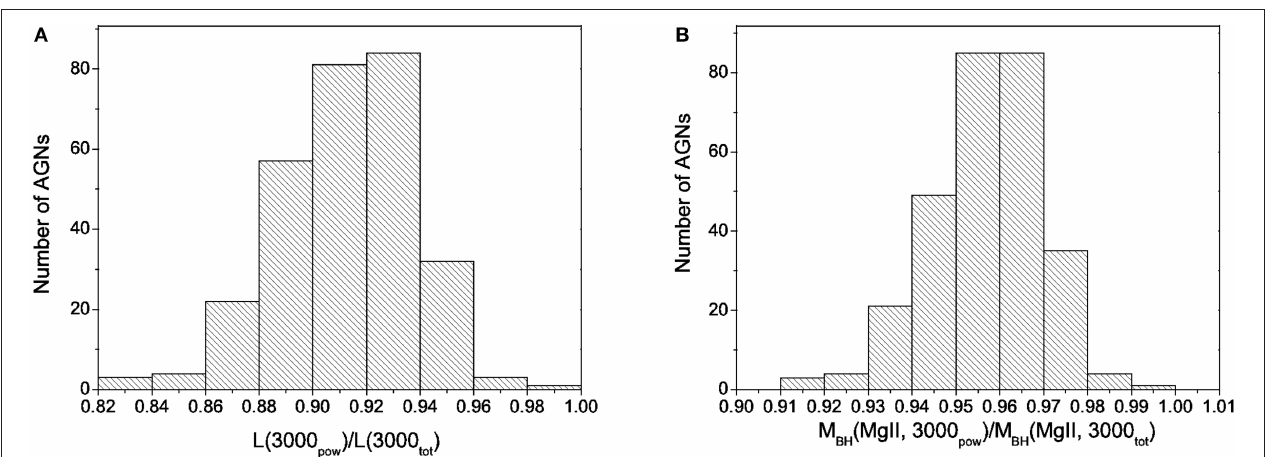
FIGURE 2 | (A) The ratio of the continuum L λ (3,000Å) before [ L (3,000 tot )] and after [ L (3,000 pow )] the Balmer continuum subtraction. (B) The ratio of the M BH estimate before [M BH ( L tot )] and after [M BH ( L pow )] the Balmer continuum subtraction.